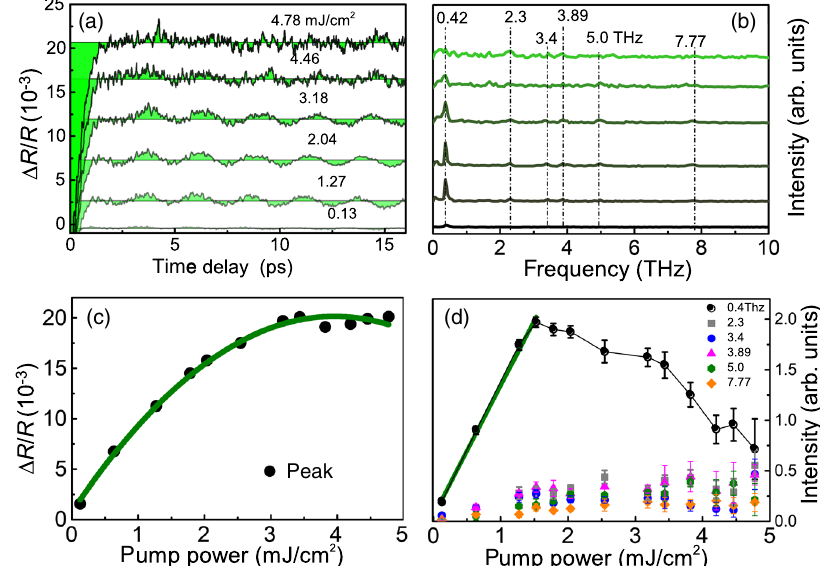
FIG. 3. The fluence-dependent coherent vibrational dynamics. (a) The transient-pump-induced reflectivity changes in MoTe 2 at 4 K with different excitation fluences. (b) The Fourier transformation of the transient reflectivity after subtracting the background in (a). (c) The fluence dependence of the maximum change of the reflectivity. The green curve is a guide to the eyes. (d) The fluence dependence of amplitudes of different phonons. The intensity increases linearly at small